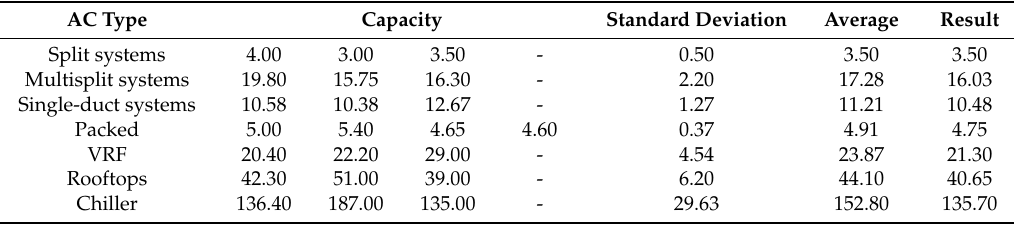
Table A4. Statistical calculations regarding the capacity per AC type, EU15, (kW),